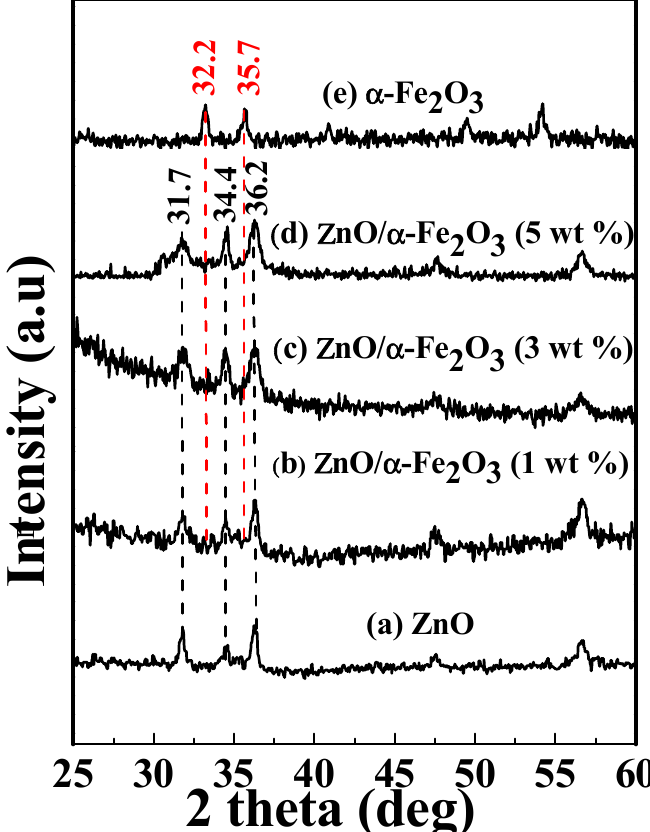
Figure 1. XRD patterns of ( a ) ZnO; ( b ) ZnO / α -Fe 2 O 3 (1 wt%); ( c ) ZnO / α -Fe 2 O 3 (3 wt%); and ( d ) ZnO / α -Fe 2 O 3 (5 wt%).